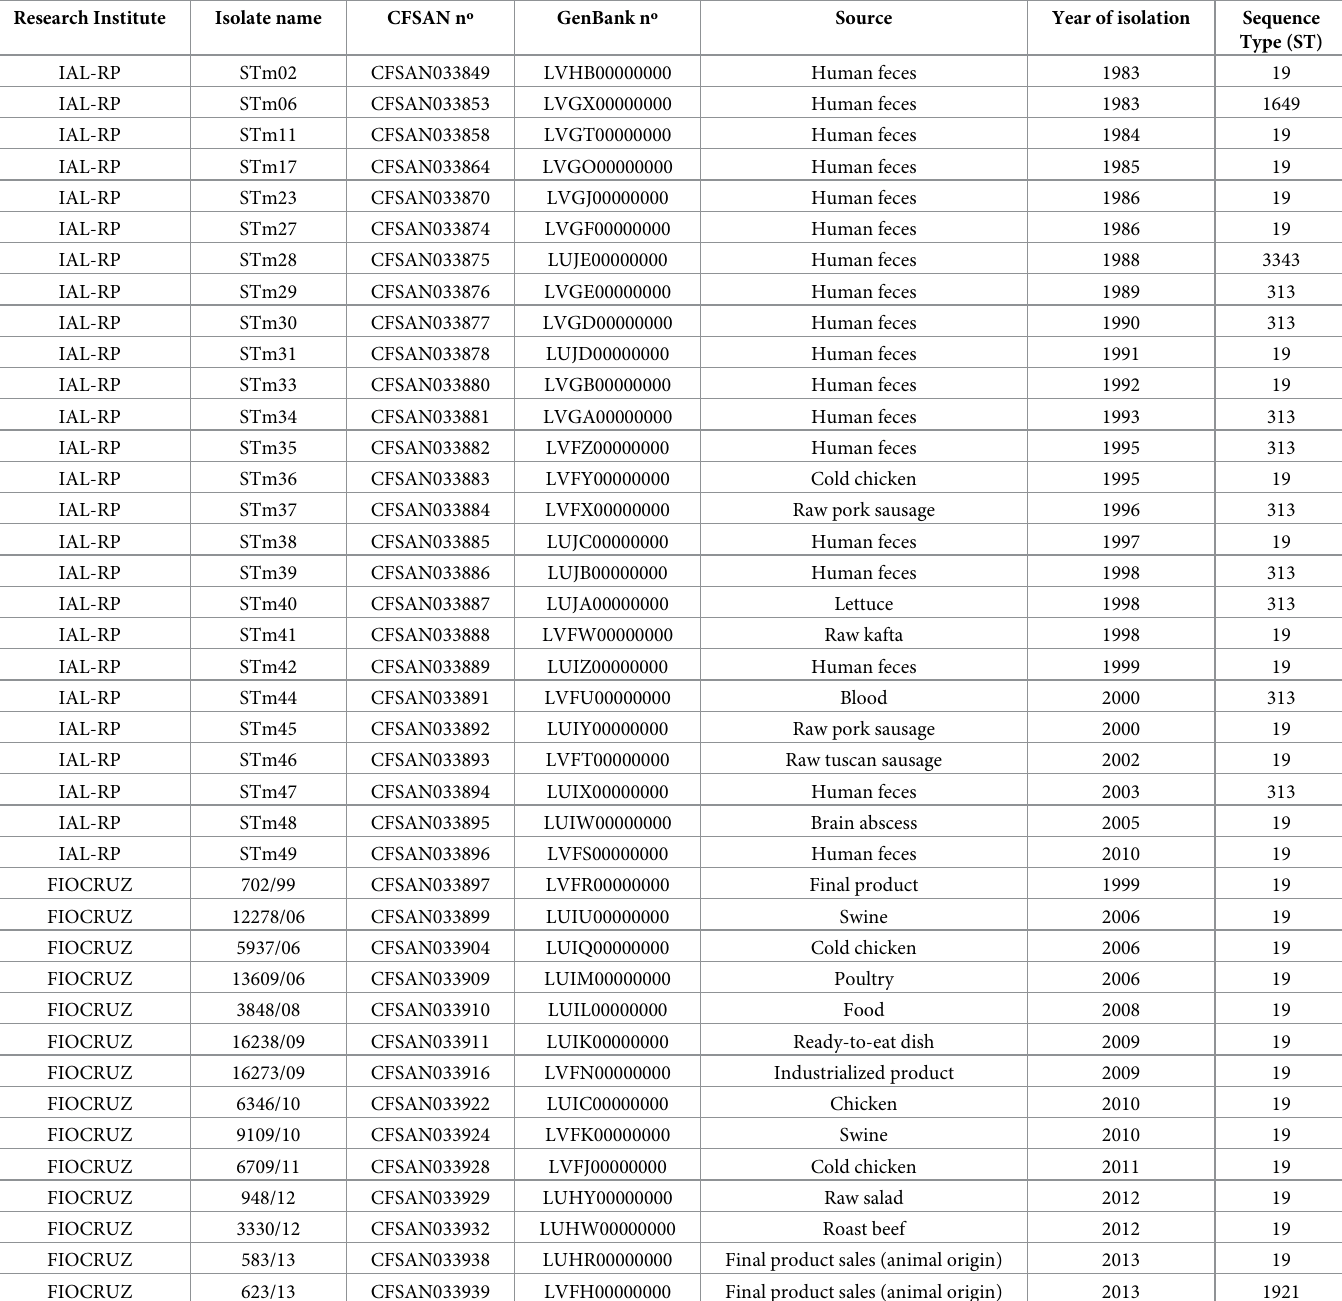
Table 1. Characteristics of the 40 Salmonella Typhimurium isolates from humans (n = 20) and foods (n = 20) in Brazil. Research